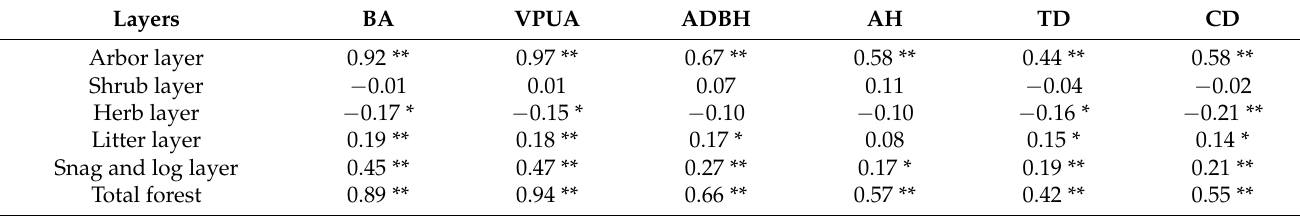
Table 7. Correlations between FVCD in each layer and stand quantitative characteristics.